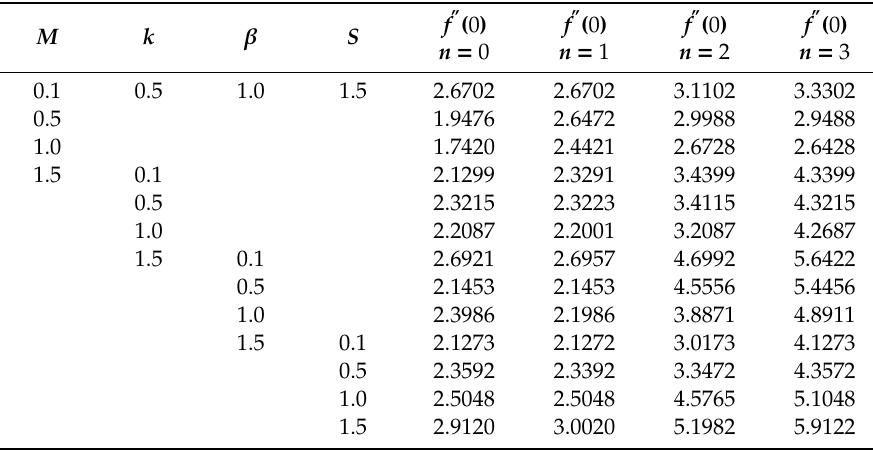
Table 7. Coe ffi cient of Skin friction for dissimilar values of M , k , β and S